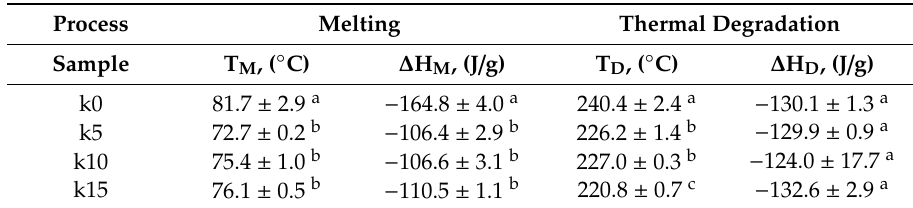
Table 3. The calorimetric